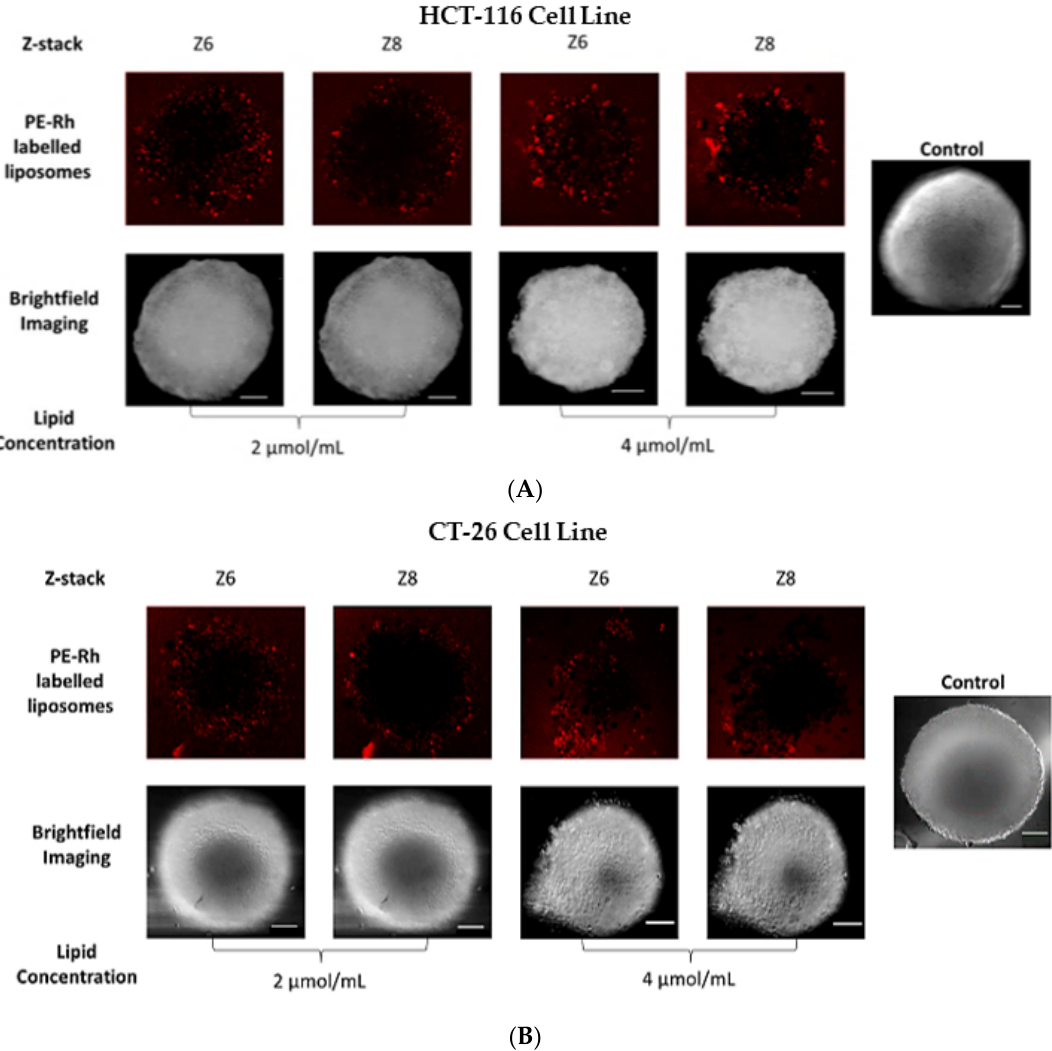
Figure 4. Liposome internalization in CRC cell line spheroids after 120 h of incubation with 2 and 4 mol/mL concentrations of [ZnL(AcO)]. Z-stack images from the periphery to the center of the spheroid, taken by confocal microscopy, show penetration of Rh-labelled liposomes in CRC human and murine cell line HCT-116 ( A ) and CT-26 ( B ) spheroids after 120 h of incubation. The red color indicates the presence of Rh-labelled liposomes. Scale bar = 100 µM.